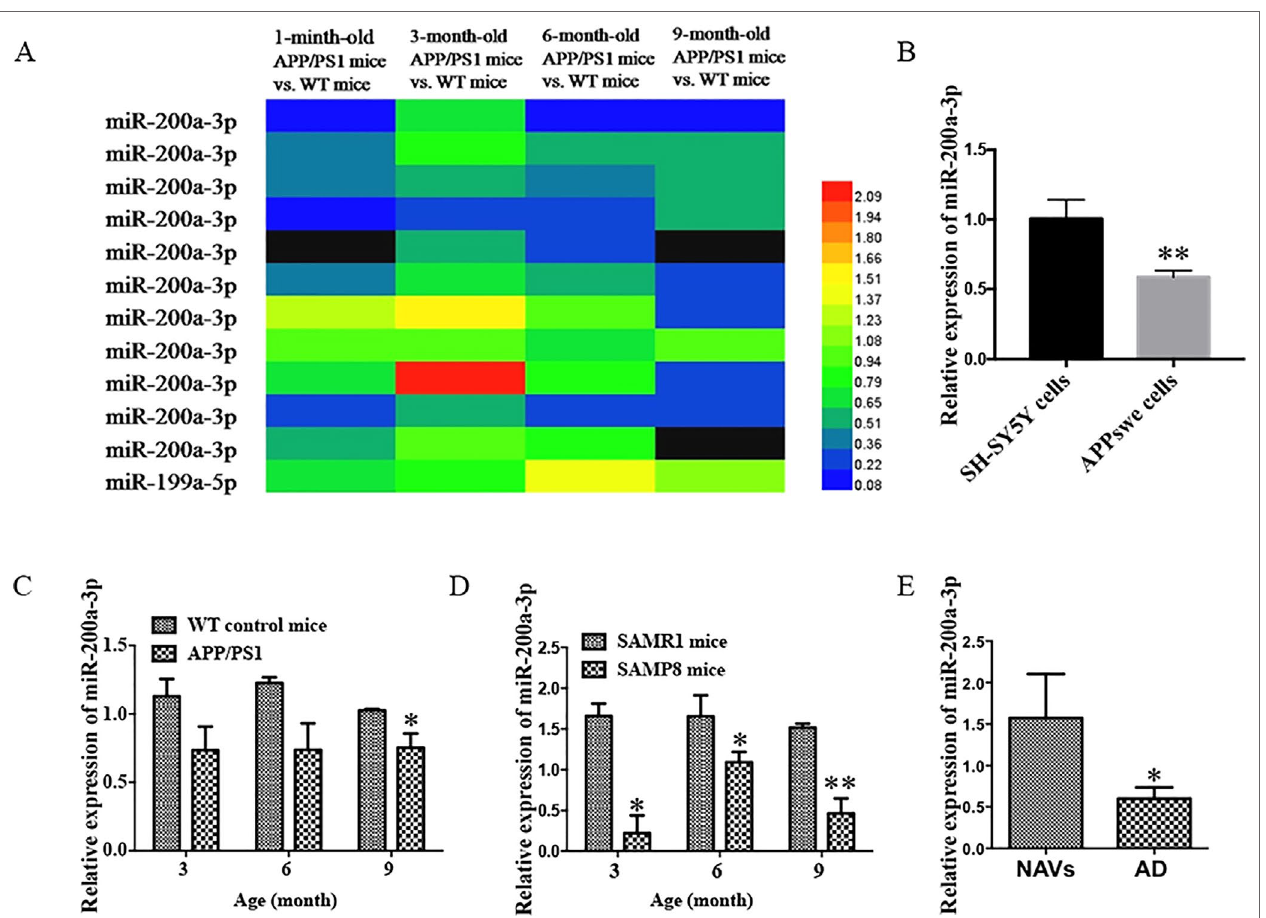
FIGURE 1 | Aberrant expression of miR-200a-3p is involved in the progression of AD. (A) Expression of miR-200a-3p in APP/PS1 mouse brains using microarray analysis at different stages of the disease process. (B) Decreased expression of miR-200a-3p in APPswe cells compared with normally cultured SH-SY5Y cells ( n = 3). (C , D) Decreased expression of miR-200a-3p in the hippocampus of APP/PS1 (C) and SAMP8 mice (D) ( n = 4). (E) Reduced levels of miR-200a-3p in the plasma of AD patients compared with normal age-matched volunteers (NAVs) ( n = 5–7). Data are shown as the mean ± SEM.* P < 0.05. ** P < 0.01 versus relevant